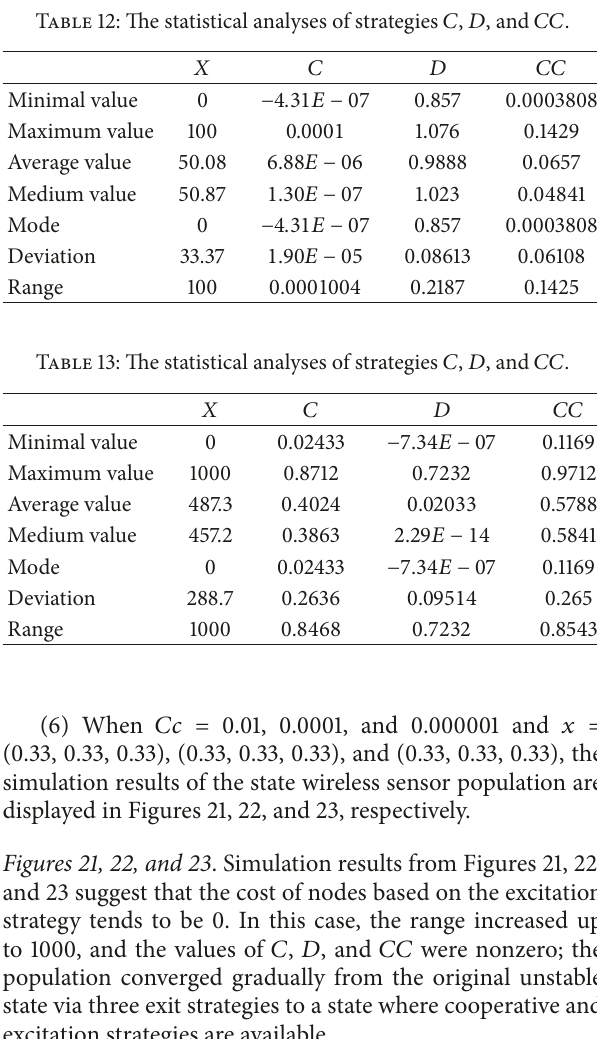
Figure 15: The state of population when 𝑋 = (0, 300, 130.2, 139.4, 0, 86.78, 300).